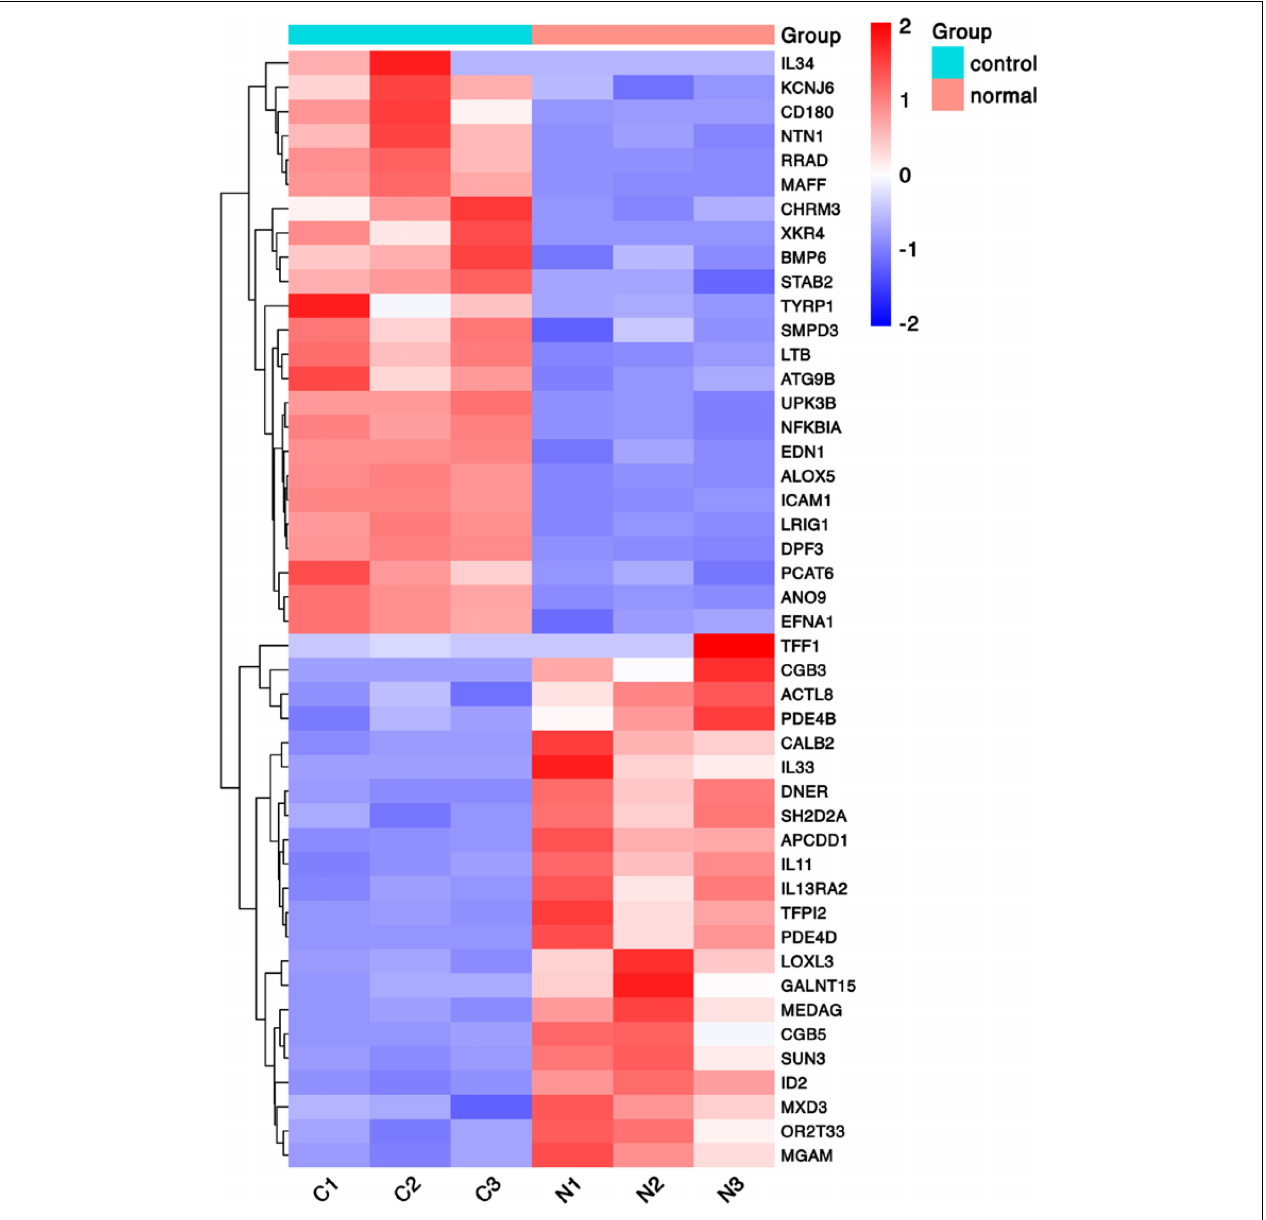
FIGURE 2 | Heat map of hierarchical clustered genes. A heat map of hierarchical clustered genes. In total, there were 46 genes from the genomics data showing a significantly aberrant expression (at least two-fold change), p < 0.05. In the clustering analysis, red and blue regions indicate the up-regulated and down-regulated genes, respectively. C1, C2, C3, and N1, N2, N3 represent the three independent repetitions of the control group and the vitreous induction group,